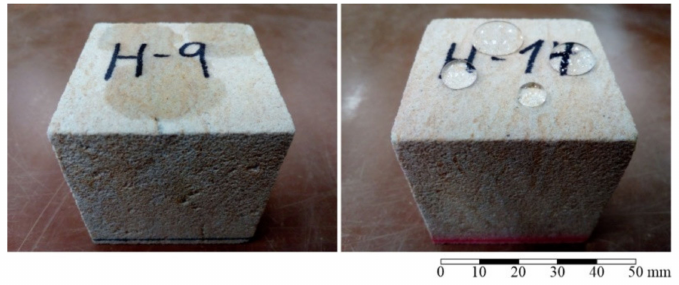
Figure 6. Hydrophobic effect of the protective coating. Wetted untreated sandstone ( left ) and sample protected by the coating A ( right